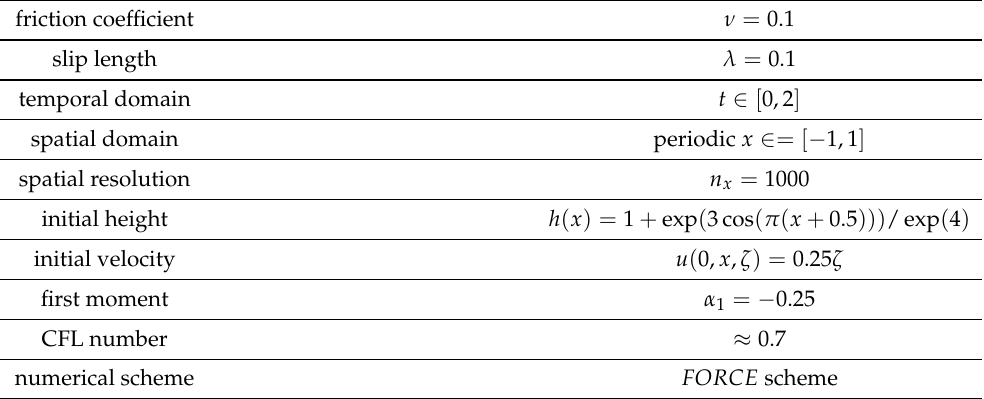
Table 2. Simulation setup for smooth periodic wave test